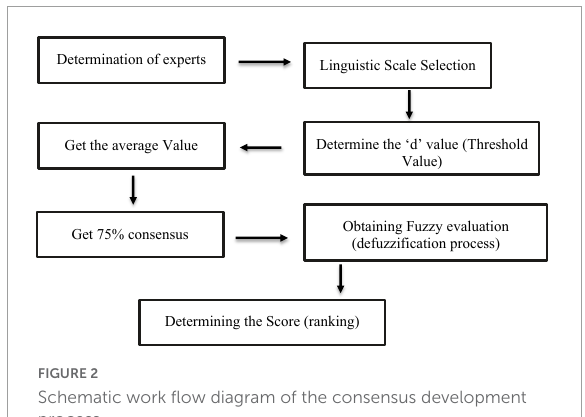
FIGURE2 Schematic work flow diagram of the consensus development